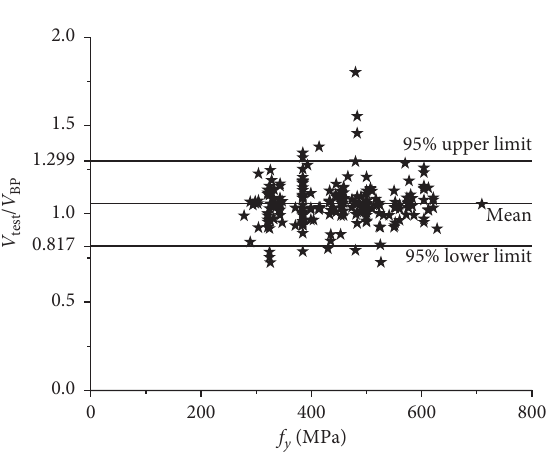
Figure 10: f y influence on the BPNN model.